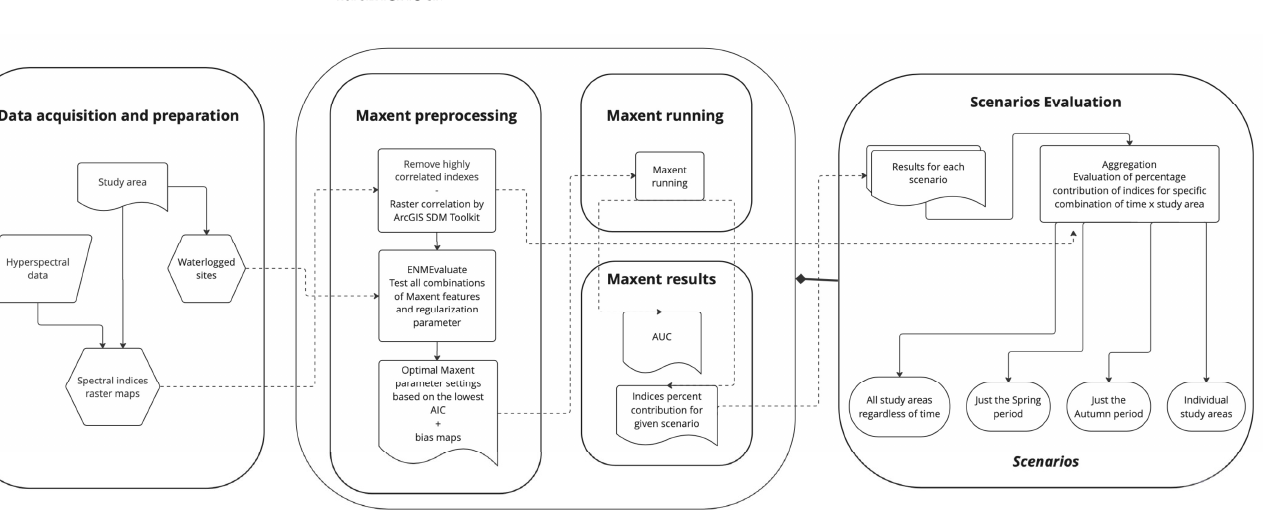
Figure 7. Process flowchart for evaluating analysis deriving raster maps of spectral indices for all the available hyperspectral images. Further selection of uncorrelated variables, testing of parameter settings, running of the Maxent model, and aggregating of all the results .